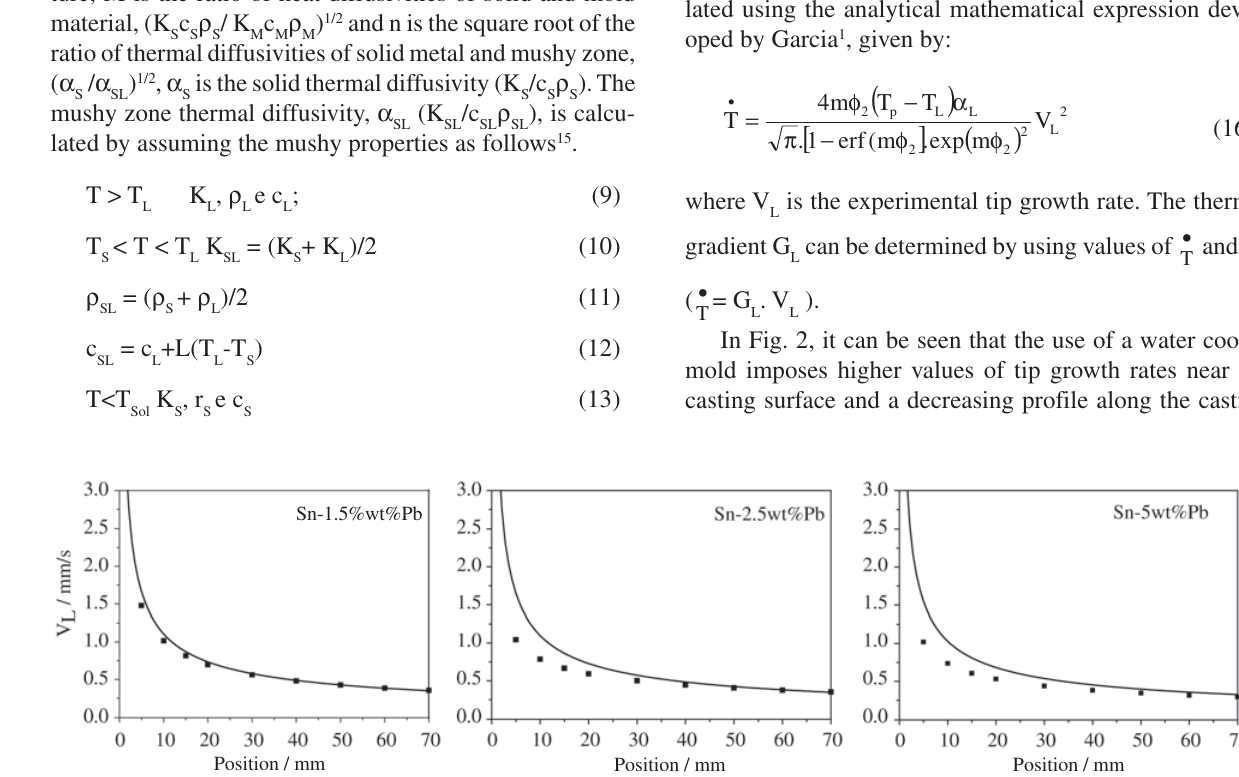
Figure 2. Comparison between experimental and analytical growth